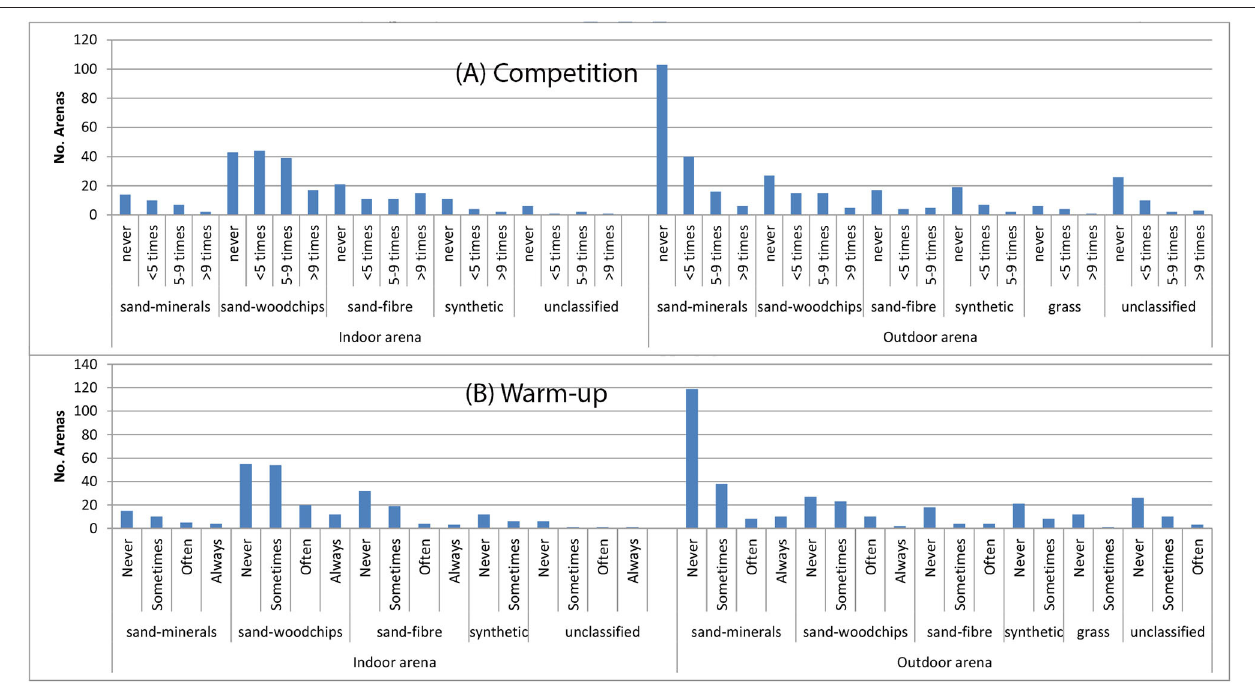
FIGURE 2 | Number of times arenas are used (A) for competition per year and (B) as warm-up for competition. Data from a pool of 656 riding arenas identified in a questionnaire in Sweden